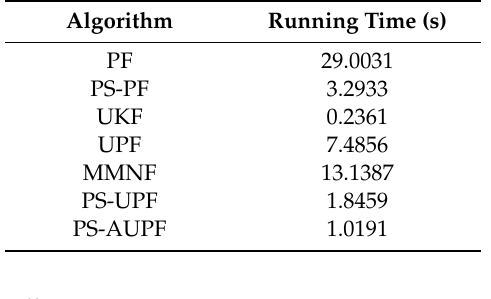
Table 5. Running time of each algorithm.